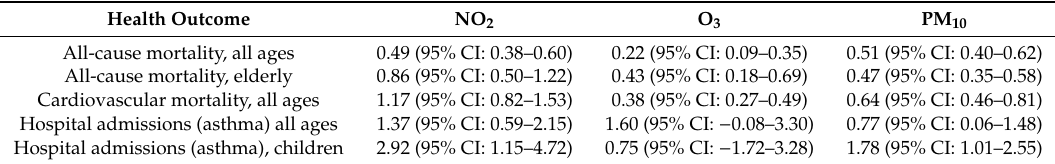
Table 2. The percentage risk increases with 95% confidence intervals (CI) associated with a 10 µ g m − 3 increase in exposure to NO 2 , O 3 , and PM 10 obtained from a meta-analysis [8]. All-cause mortality and hospital admissions for asthma are divided into all ages and elderly, and all ages and children, respectively. Cardiovascular mortality is presented for all ages